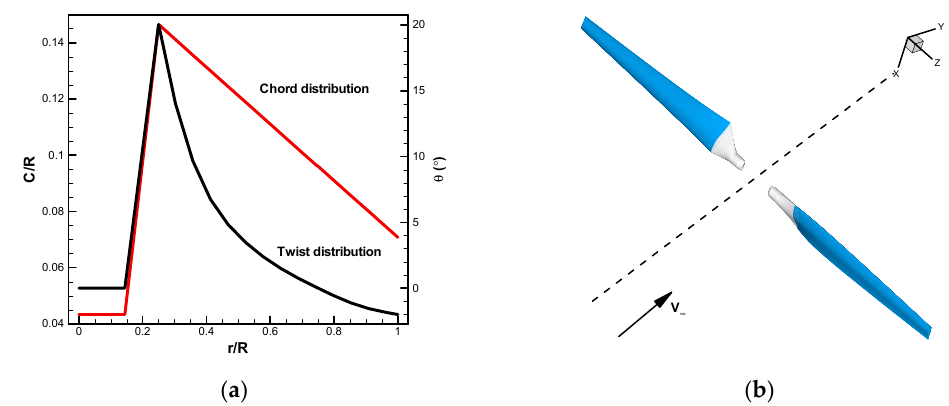
Figure 8. National Renewable Energy Laboratory (NREL) Phase VI wind turbine blade: ( a ) distributions of chord length and twist angle; ( b ) geometric shape of blade.